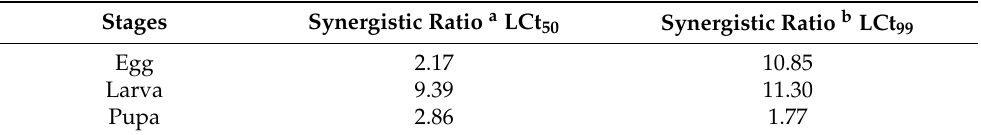
Table 4. Synergistic ratios of methyl bromide and cold treatment on each growth stage of D. suzukii .